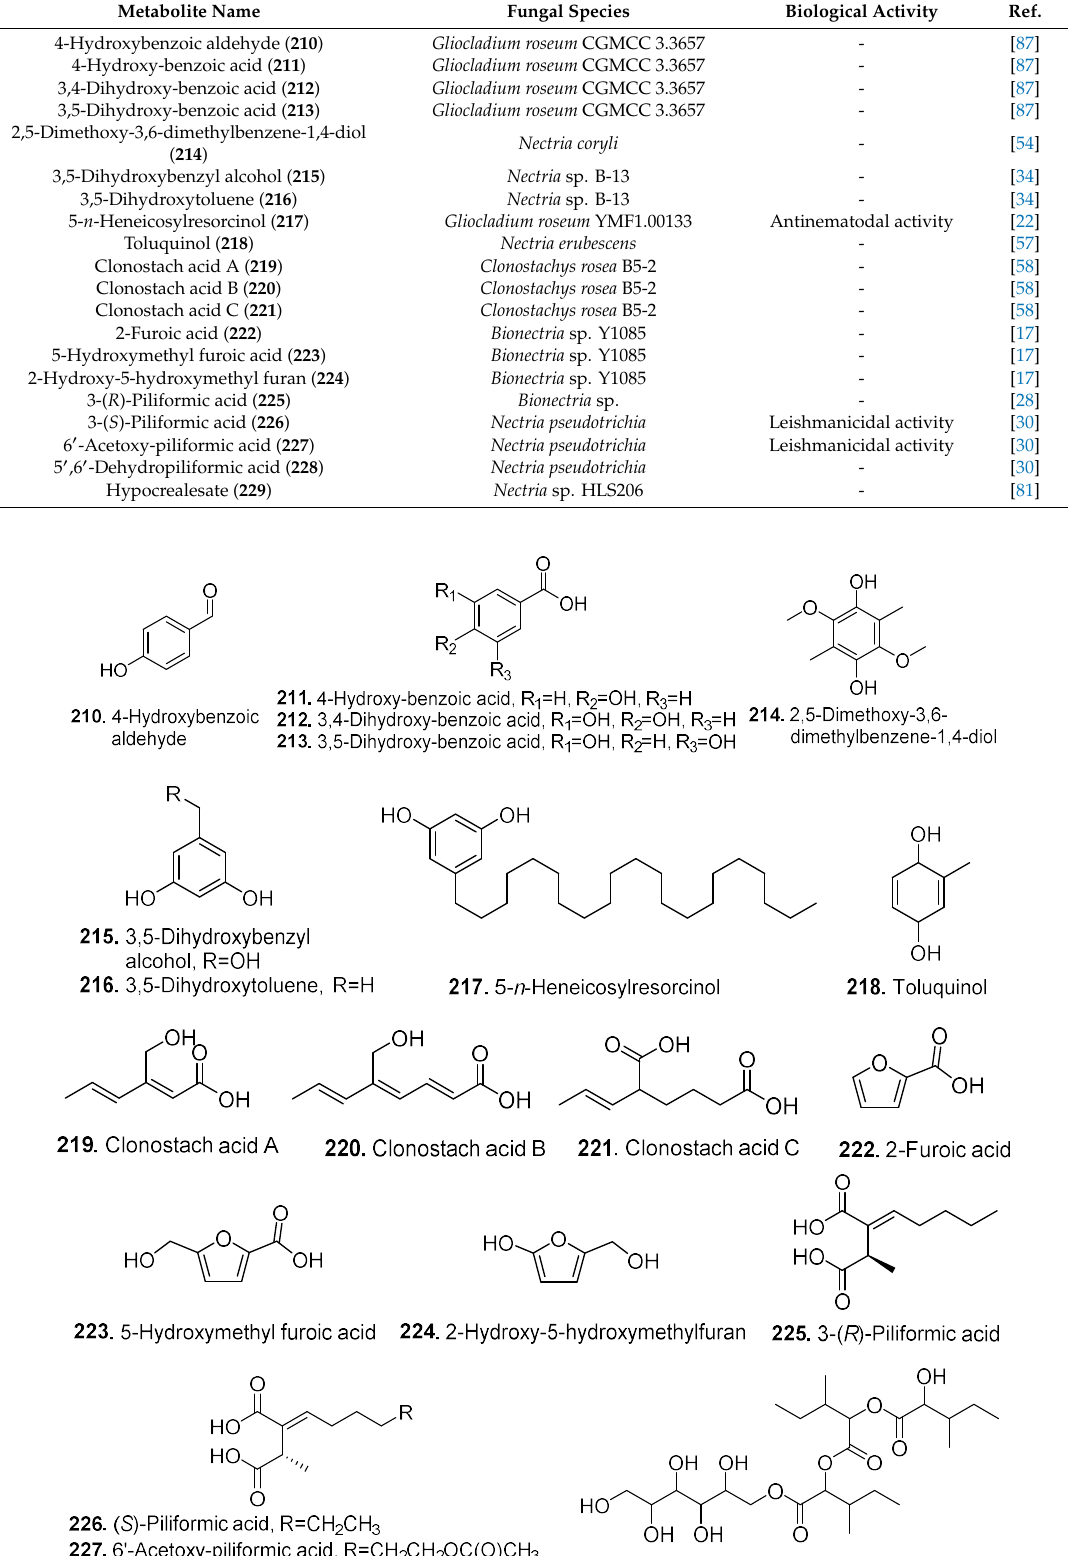
Table 4. Miscellaneous metabolites in Clonostachys fungi and their biological activities.